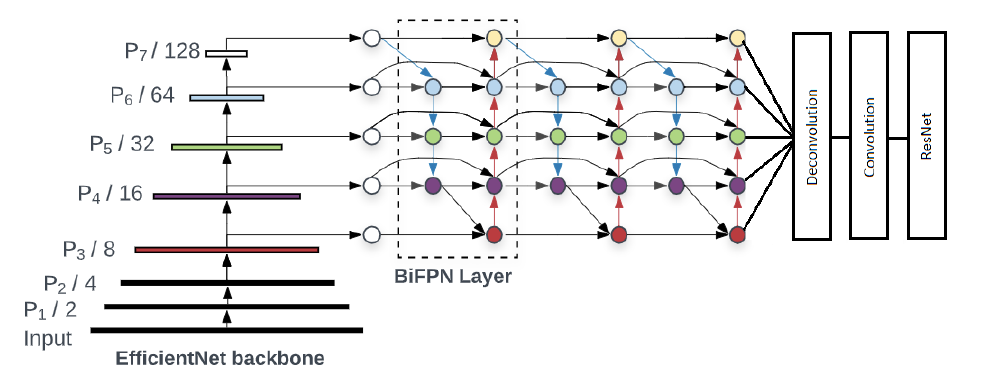
Figure A7. EfficientClassification